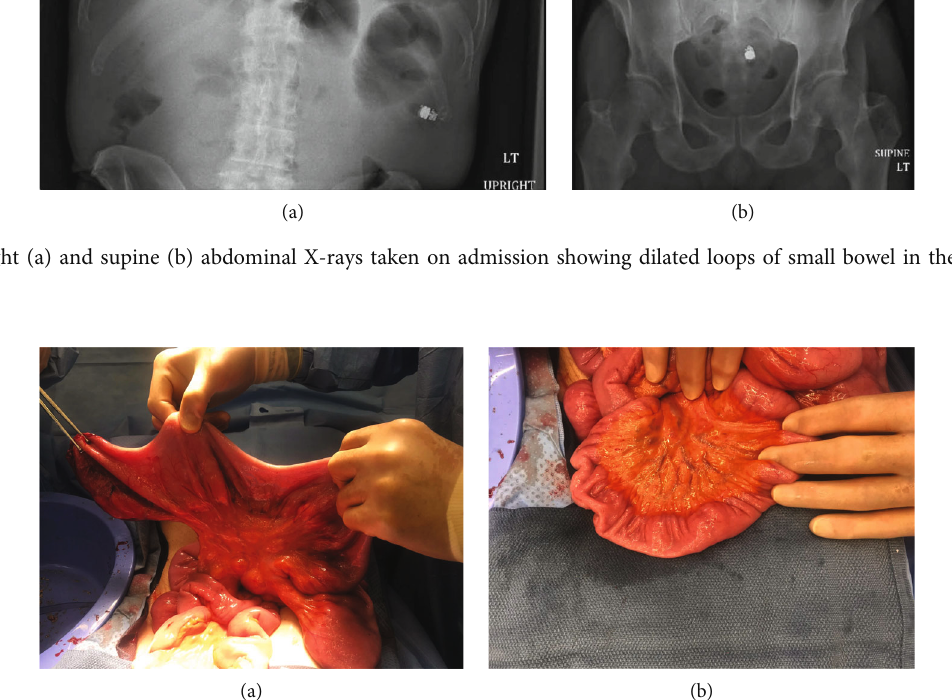
Figure 2: Intraoperative pictures documenting markedly dilated loops of small bowel proximal to the tumor (a) and normal loops downstream